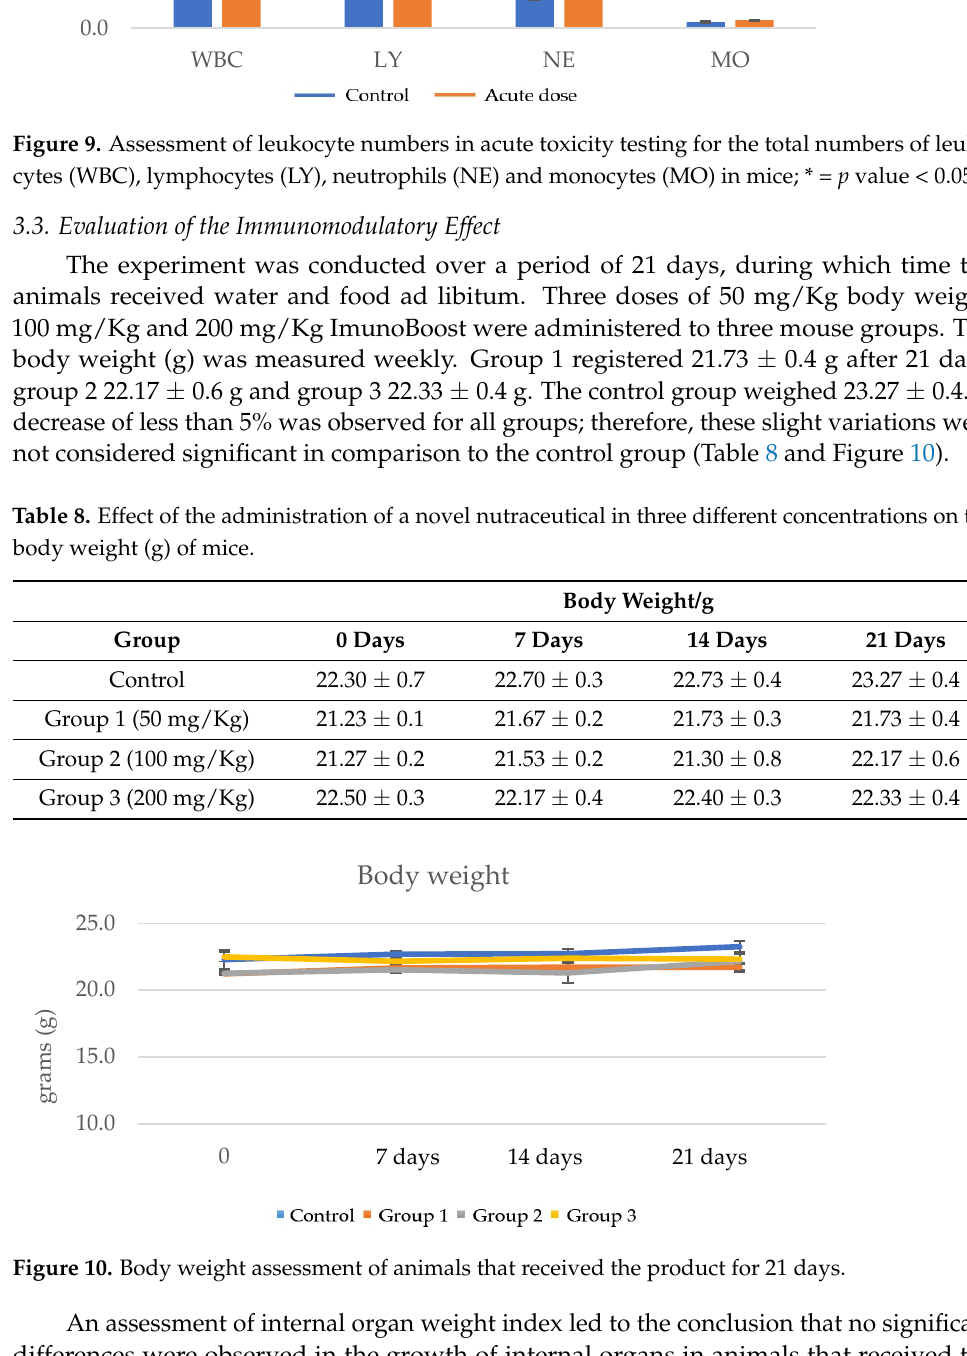
Table 9. Effect of administration of novel nutraceutical in three different concentrations on the organ weight index (mg / g) in mice .